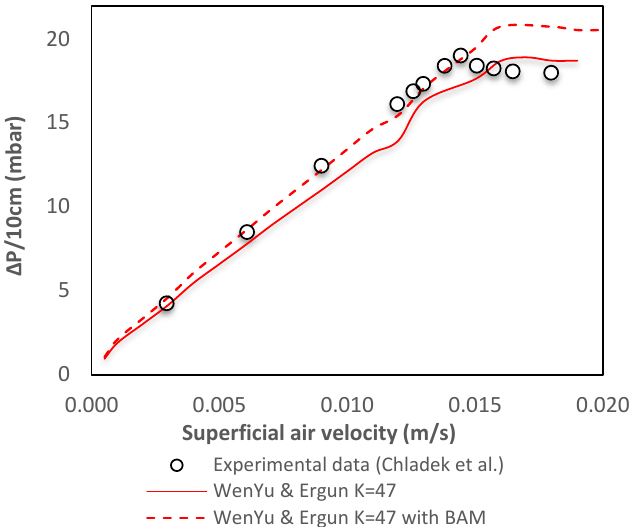
Figure 16. Change of the pressure drop in the bed with increased superficial air flow rate, with and without BAM .